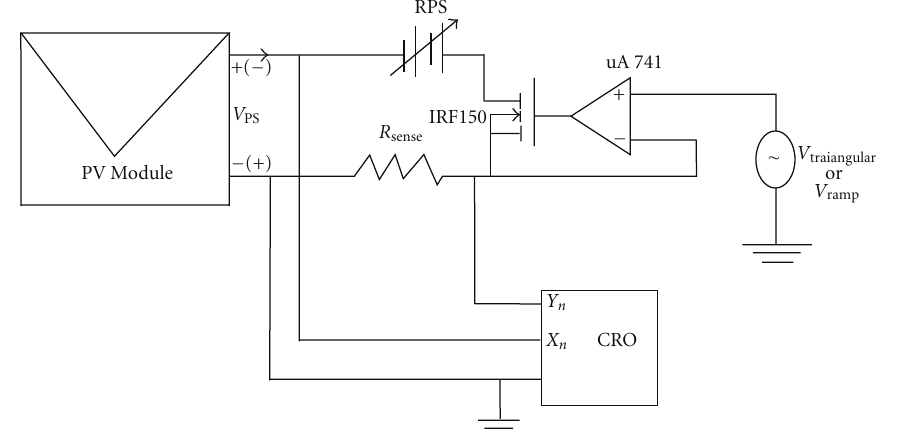
Figure 8: Circuit for obtaining the experimental characteristics of PV module.